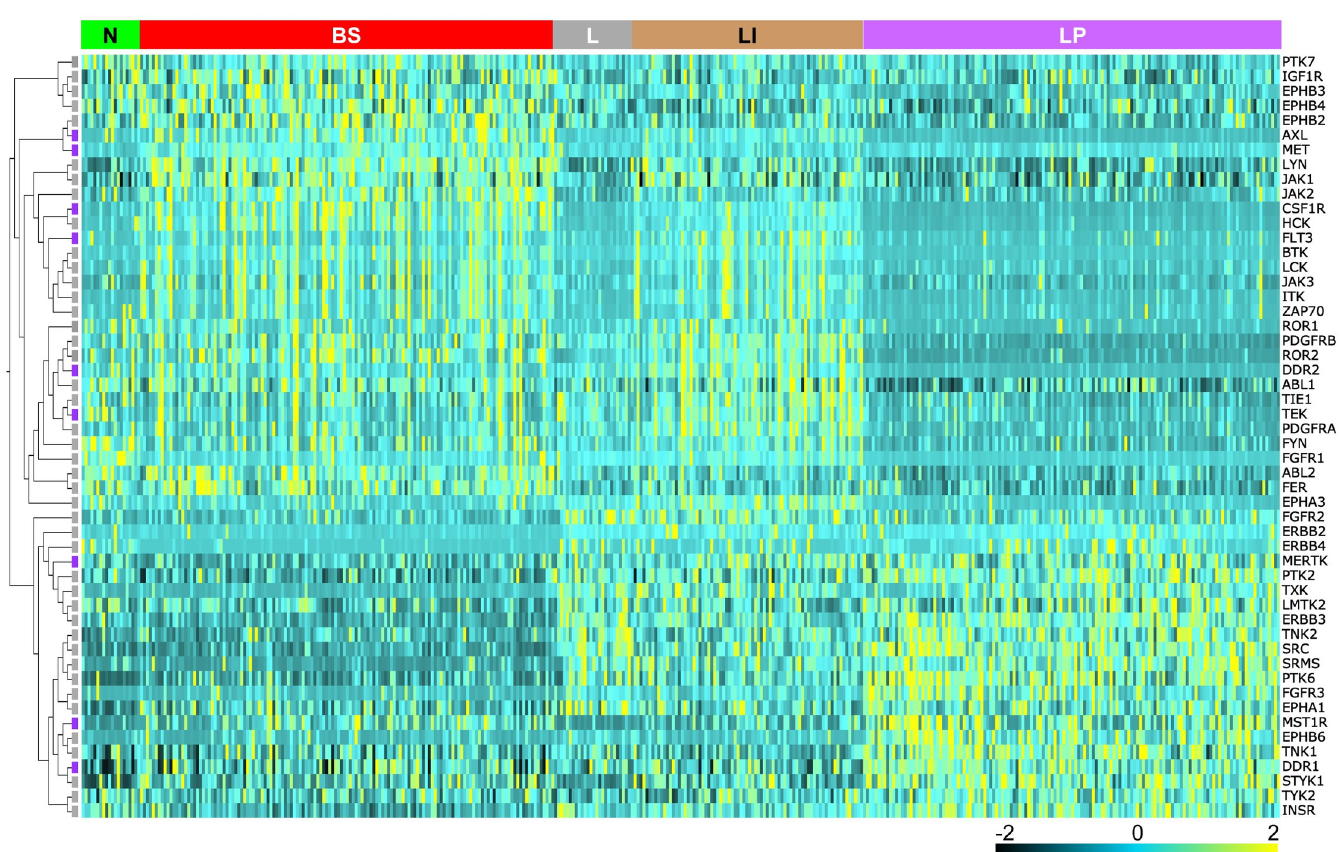
Fig 1. Heat map of relative TK mRNA expression levels among MIBC patient tumor samples. TCGA data for MIBC patient tumor samples (n = 408) reported previously [22]. TK gene symbols are listed vertically at right. Samples are grouped on the horizontal axis by mRNA subtype classifications as defined by Robertson et al. [22] indicated at the top (from left to right): neuronal (N, green); basal squamous (BS, red); luminal (L, gray); luminal infiltrating (LI, gold); luminal papillary (LP, purple). TK genes are clustered hierarchically; in the cladogram at left cabozantinib targets are designated with violet squares.